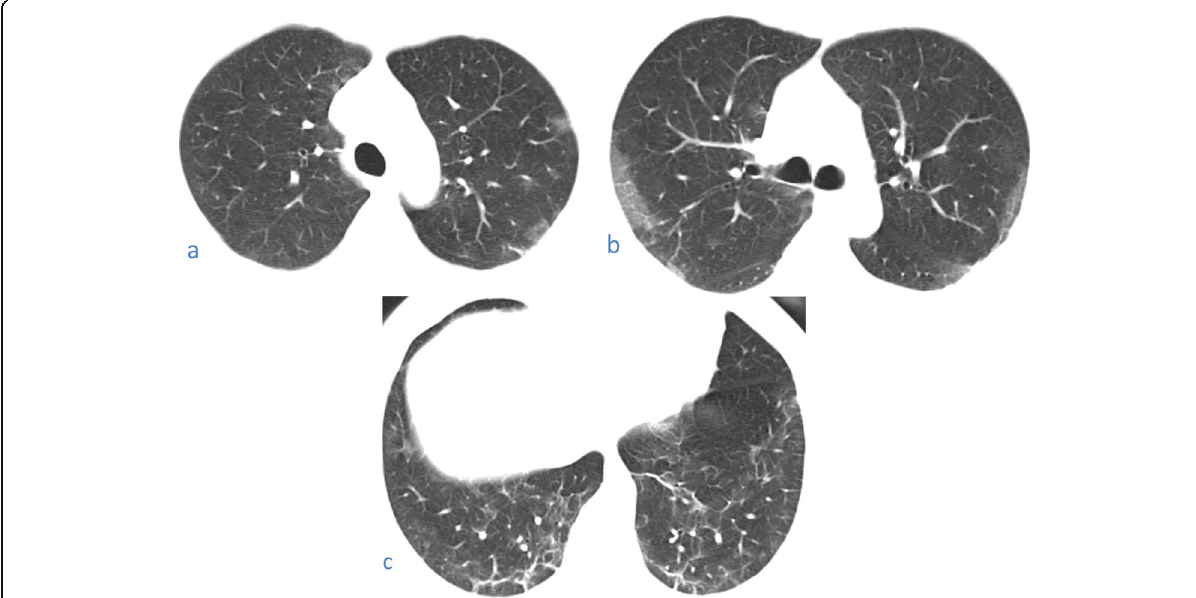
Fig. 12 A 50-year-old female patient with COVID-19, known patient of bronchial asthma presented with 10 days of fever, CT chest axial image ( a ) shows left upper lobe subpleural ground glass opacities with vascular thickening ( b ) shows bilateral subpleural crazy paving and ( c ) shows bilateral basal subpleural arcade opacities; perilobular thickening and mild architectural